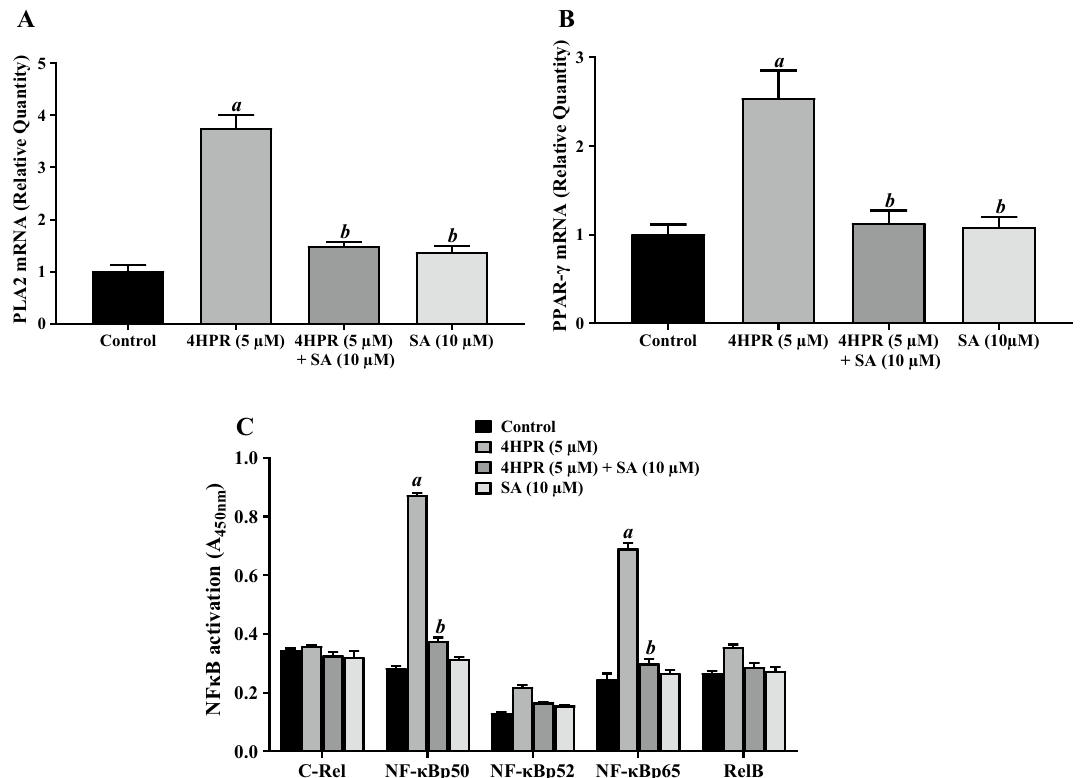
Figure 6. Fenretinide-induced PLA 2 and PPARγ mRNA expression and activation of NF-κB in ARPE-19 cells are prevented by pretreatment with sterculic acid. ( A ) Fenretinide-induced PLA 2 mRNA expression is prevented by pretreatment with sterculic acid (SA). ( B ) Fenretinide-induced PPARγ mRNA expression is prevented by pretreatment with SA. ARPE-19 cells were treated with 5 μM fenretinide (4HPR) in the presence or absence of SA, and the total RNA preparations were analyzed by qPCR as described under “Experimental Procedures”. ( C ) Fenretinide-induced NF-κB activation is prevented by pretreatment with SA. The cells were treated in the presence or absence of SA, and NF-κB activation was quantified using a TransAM NF-κB kit as described under “Experimental Procedures”. The values are mean ± SD of three independent experiments performed in duplicate. To test for significant differences between treatment groups, one-way analysis of variance (ANOVA) was used. In the graphs, ‘ a ’ indicates statistical significance difference between fenretinide treated and untreated controls, and ‘ b’ between fenretinide treated and fenretinide treated + SA, or SA alone ( a,b p <